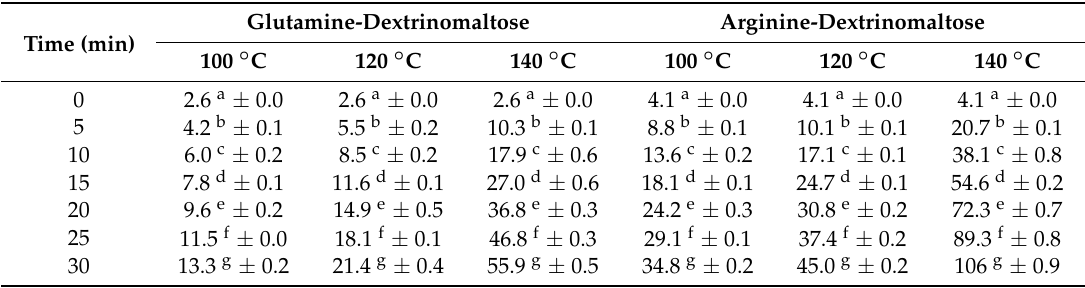
Table 6. Fluorescence intensity evolution. Values are means ± SD, n = 3; Different letters within a column indicate significant differences between groups ( p <